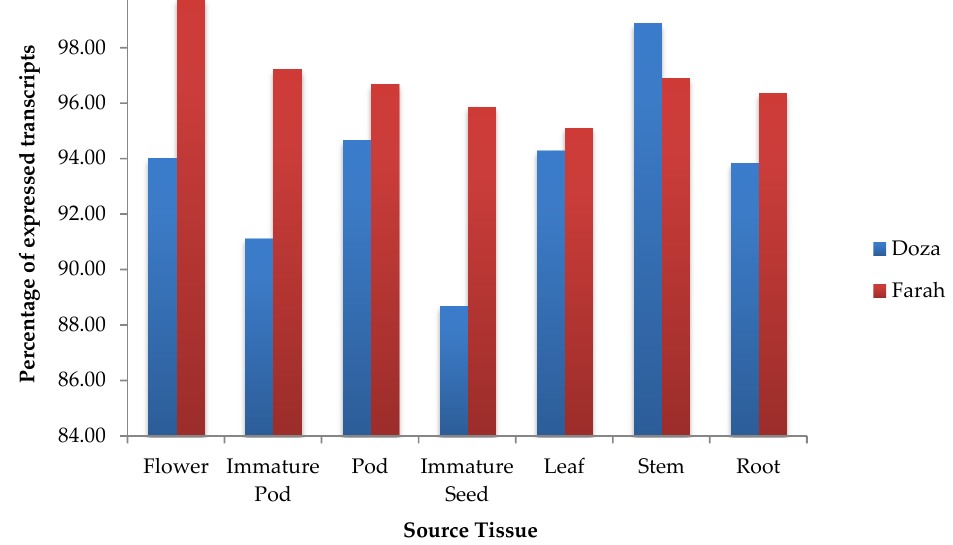
Figure 3. Differences in the level of gene expression observed from various tissue samples for Doza and Farah reference transcriptome assemblies.